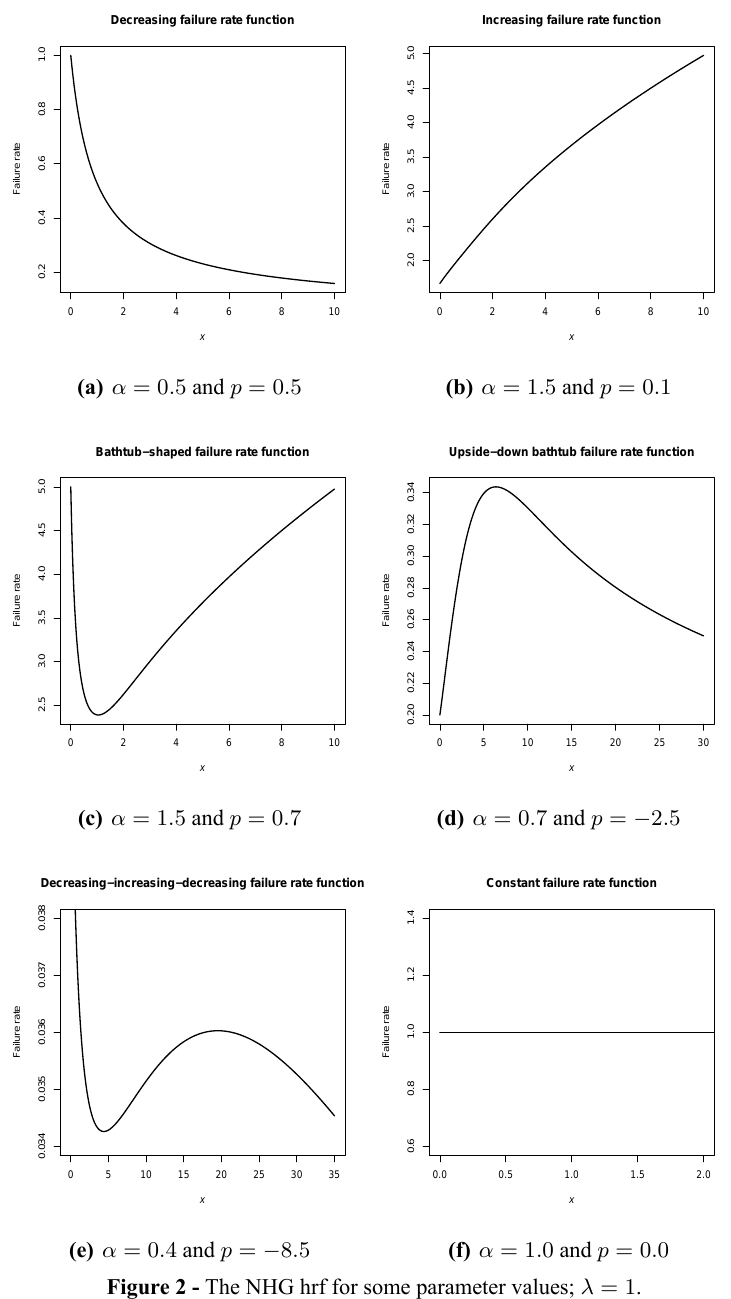
Figure 2 - The NHG hrf for some parameter values; λ = 1